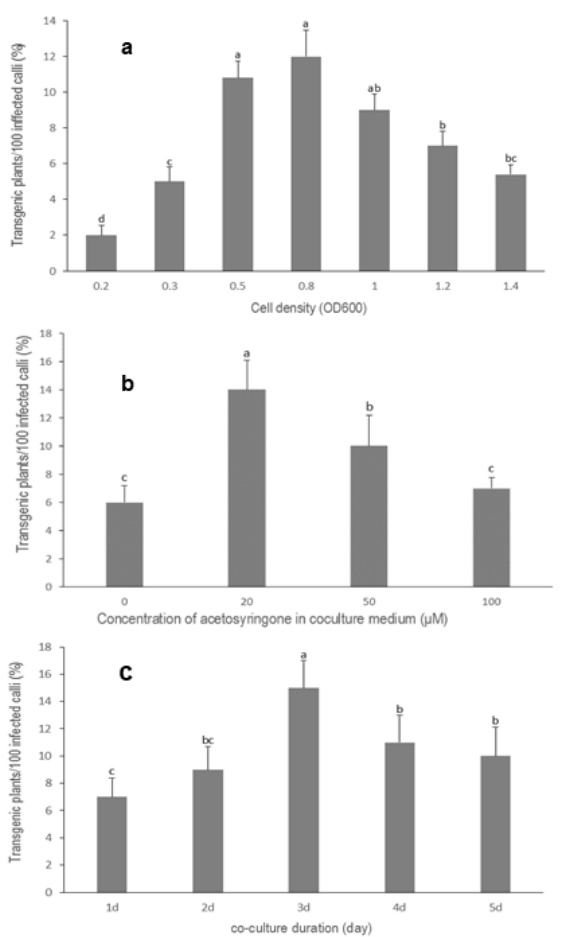
Figure 5. Factors influencing transformation efficiencies of Veratrum dahuricum . Treatments (means ± SD) followed by a different letter are significantly different according to the LSD test ( p < 0.05). ( a ) Influence of Agrobacterium cell density on transformation efficiency (n = 933), ( b ) effects of acetosyringone on transformation efficiency (n = 500), ( c ) influence of co-culture duration on transformation efficiency (n = 633).